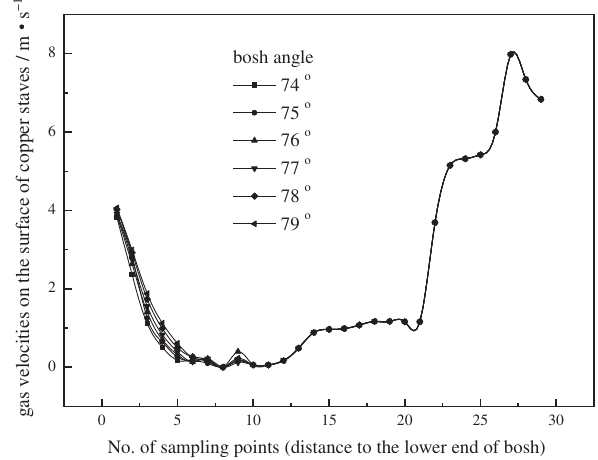
Figure 3: The velocities of the gas flow on the surface of the cooling stave under different conditions of variational Bosh angles.